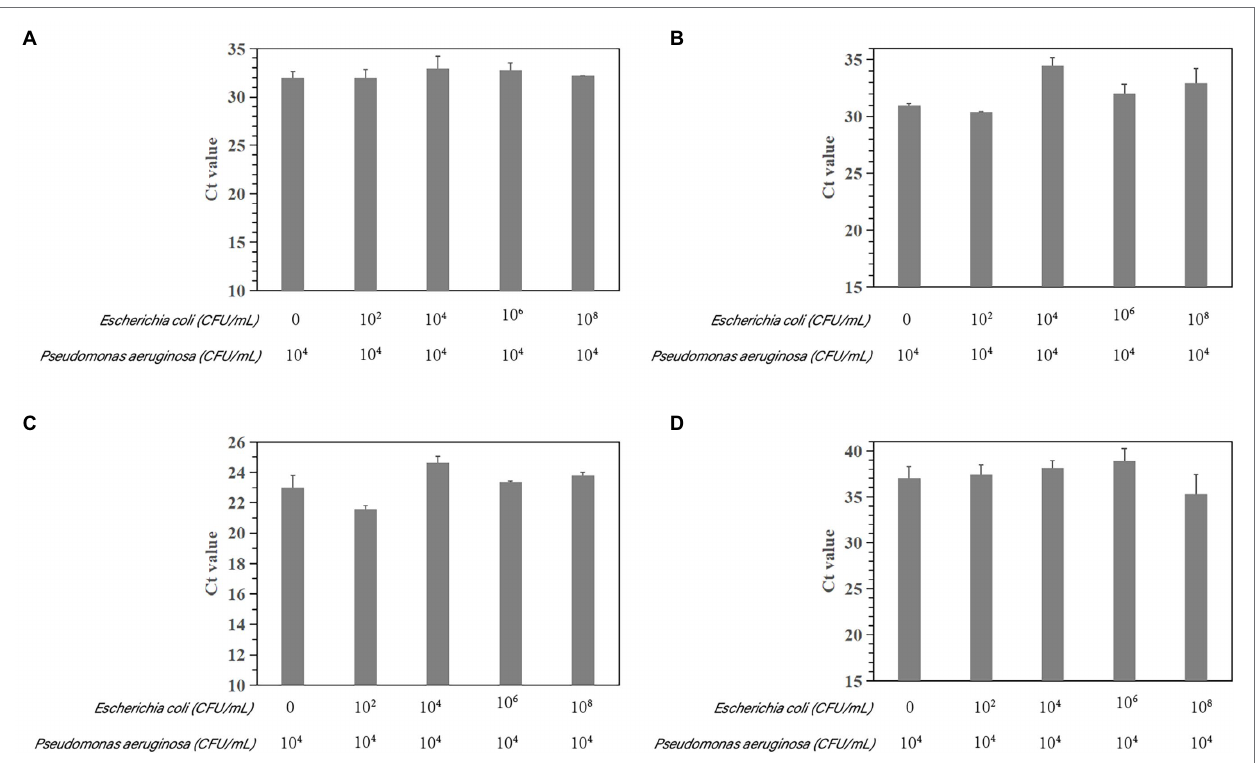
FIGURE 8 | Assessment of interference with the real-time PCR-based detection of P. aeruginosa by coinfection with E. coli ATCC 25922. Detection of P. aeruginosa ATCC 15442 (4.6 × 10 4 CFU/ml) in the presence of E. coli ATCC 25922 (0, 1.9 × 10 2 CFU/ml, 1.462 × 10 4 CFU/ml, 1.462 × 10 6 CFU/ml, and 1.462 × 10 8 CFU/ml). (A) Primer set PA12 mixed with E. coli ATCC 25922; (B) primer set PA13 mixed with E. coli ATCC 25922; (C) primer set PA14 mixed with E. coli ATCC 25922; and (D) primer set PA15 mixed with E. coli ATCC